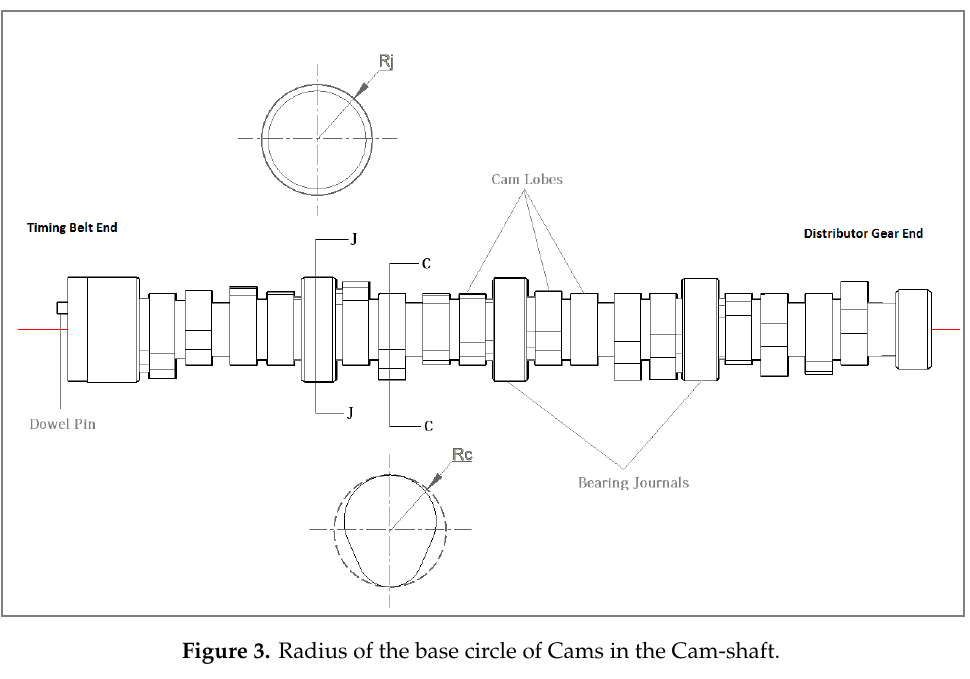
Figure 3. Radius of the base circle of Cams in the Cam-shaft.